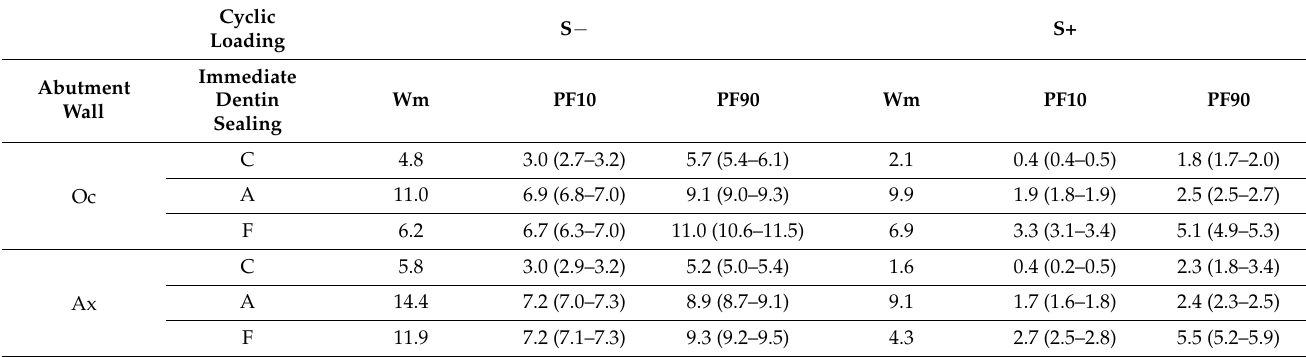
Table 3. Weibull parameter values of each experimental